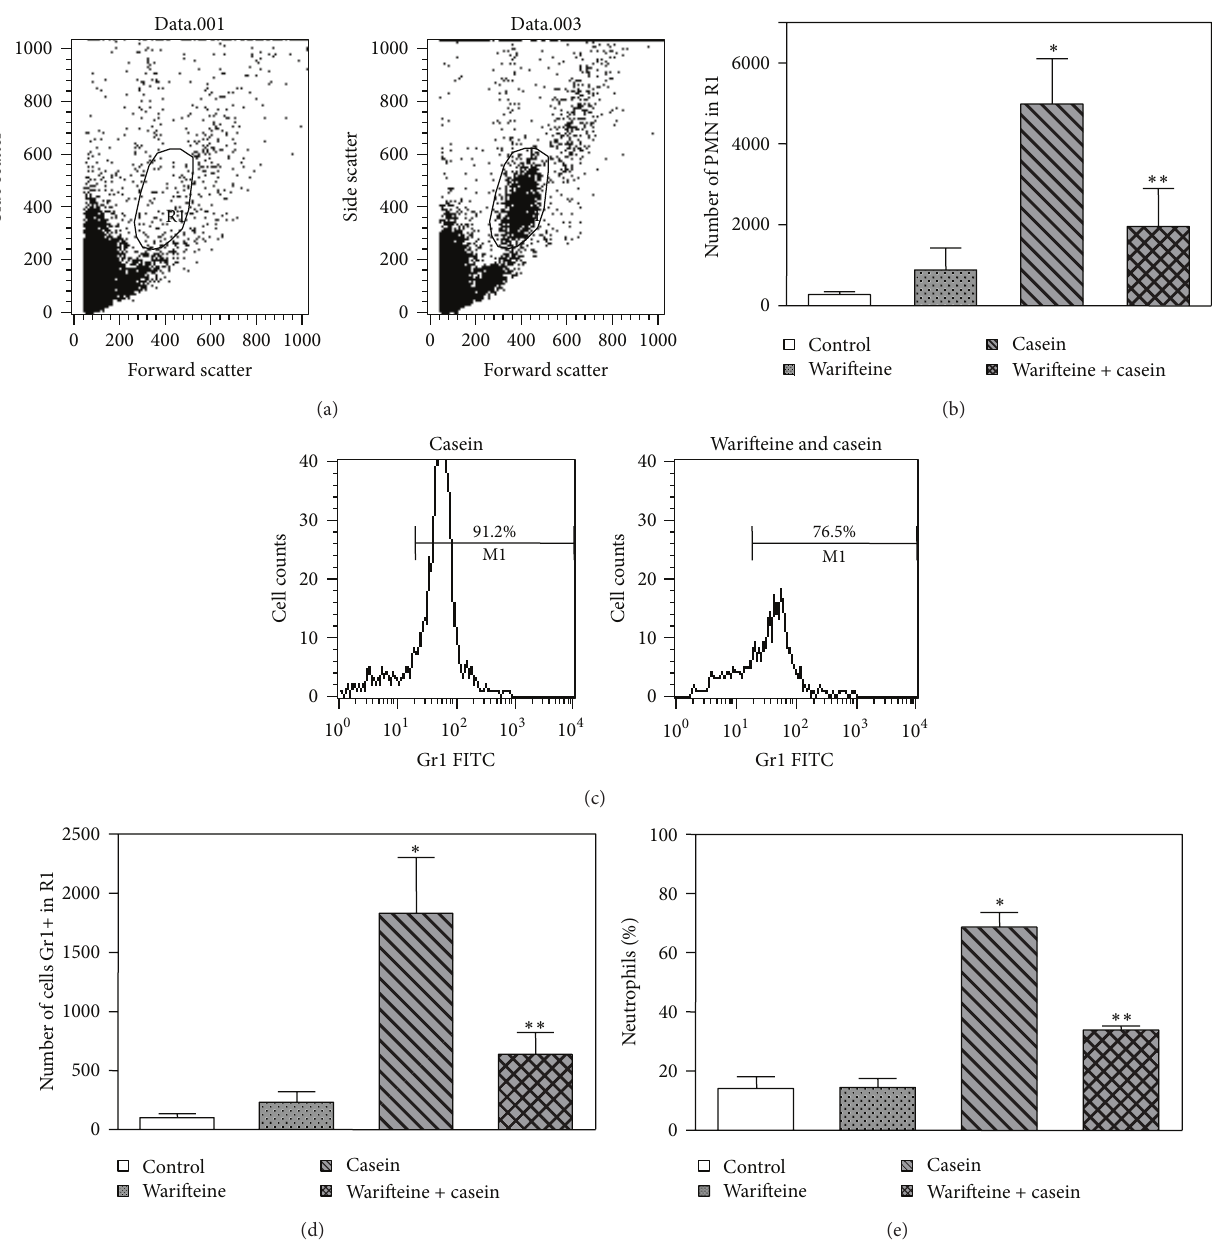
Figure 2: Neutrophil number in the peritoneal cavity of mice treated with casein and warifteine. (a, b) Cell number evaluation by flow cytometry. Peritoneal cells were obtained from mice after treatment with warifteine and casein. The cells were prepared for analysis by flow cytometry.(a)Sidescatterandforwardscatterprofilesofnormal(left)andcasein-treated(right)animalstoindicatetheR1gate.(b)TotalPMN cell number intheR1gate(asdefined in (a)).TheFSCversusSSCplotsarerepresentative ofthreeindependent experiments. Themean value of neutrophil numbers in R1 gates from three independent experiments is shown ( 𝑛 = 3 animals per group/experiment). ∗ 𝑃 ≤ 0.05 as compared to untreated controls and ∗∗ 𝑃 ≤ 0.05 as compared to casein-treated animals. (c) Analysis of the percentage of Gr1+ cells in the peritoneal cavity fluid from animals treated with casein and warifteine. Peritoneal fluid was obtained from warifteine and casein-treated animals. The samples were incubated with an anti-Gr1-FITC labeled antibody. Histograms show the Gr1-expressing cells in the R1 gate. The value shown in M1 indicates the percentage of Gr1+ cells. Data shown in the histogram plots are representative of two independent experiments. (d) Quantification of the number of Gr1+ cells in the R1 gate. Data shown indicate the total number of GR1+ cells from experiments shown in (a) and are the mean value from two experiments ( 𝑛 = 4 animals per group/experiment): ∗ 𝑃 ≤ 0.05 in comparison with control animals and ∗∗ 𝑃 ≤ 0.05 in relation to animals treated with casein alone. (e) Percentage of neutrophils in peritoneal exudate obtained from mice treated with casein and warifteine. Peritoneal exudates were obtained after a treatment with warifteine and casein and were submitted to cytospin followed by May-Grunwald Giemsa staining. Data in (e) show the percentage of neutrophils in the samples obtained by differential cell count. Data shown are mean value from six independent experiments ( 𝑛 = 3 animals per group/experiment). ∗ 𝑃 ≤ 0.05 when comparing with untreated controls and ∗∗ 𝑃 ≤ 0.05 when comparing data with those from the group treated with casein